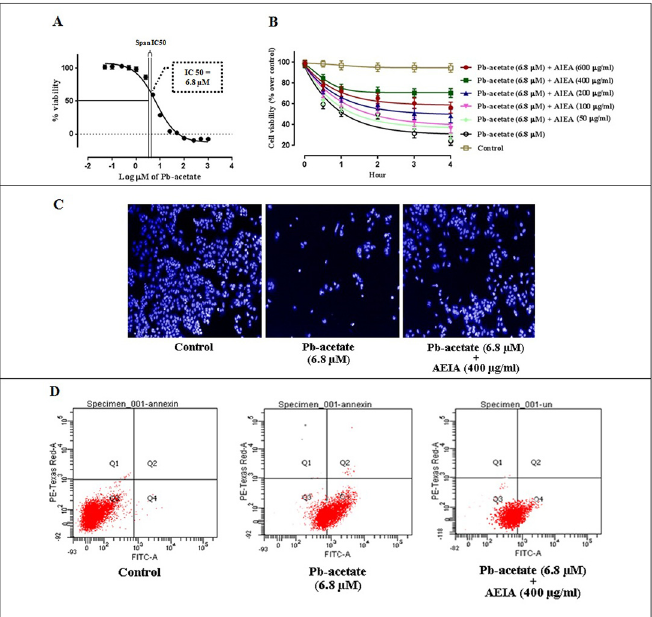
Fig 1. Cell viability studies in the absence (Pb-acetate) and existence of AEIA (Pb-acetate + AEIA) in vitro . Panel A. Effect of Pb-acetate at different concentrations in cell viability in mouse hepatocytes. Panel B. Concentration and time-dependent effect on cell viability studies in the absence (Pb-acetate) and existence of AEIA in isolated murine hepatocytes. Values are denoted as mean ± SE (n = 3). Panel C. Hoechst staining of murine hepatocytes in the absence (Pb-acetate) and existence of AEIA (Pb-acetate + AEIA). Panel D. Percentage distribution of apoptotic and necrotic cells in the absence (Pb-acetate) and existence of AEIA (Pb-acetate + AEIA) by